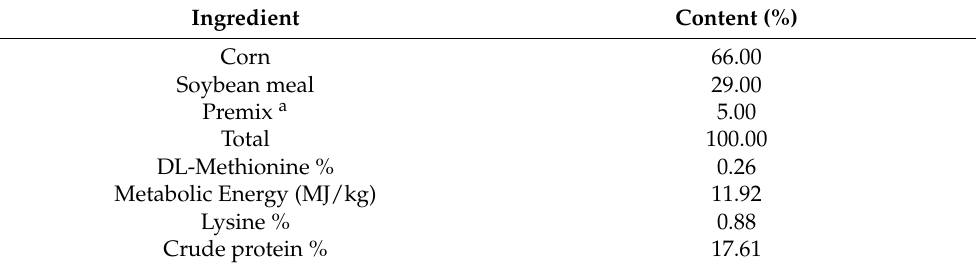
Table 1. The elements and amounts of nutrients in the basic diet for chicks. Ingredient Content (%) Corn 66.00 Soybean